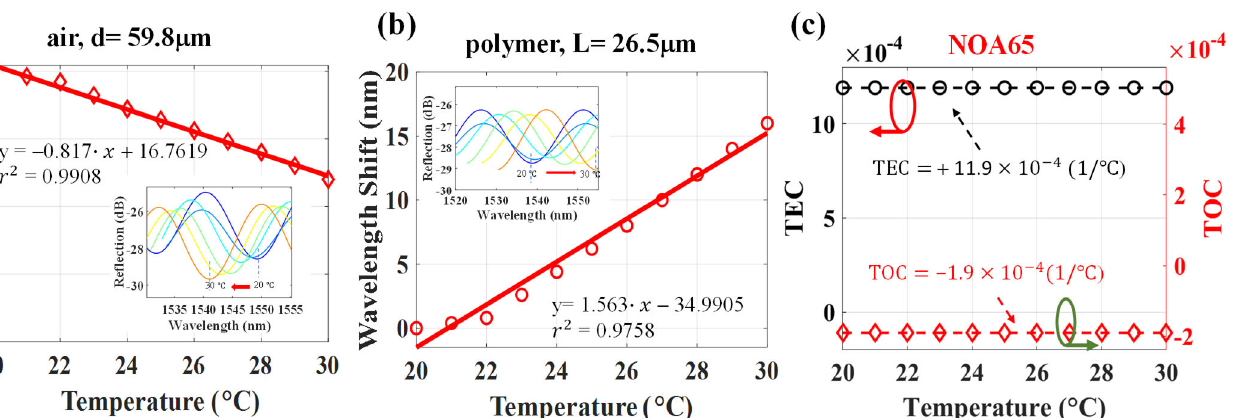
Figure 5. Wavelength shifts from 20 °C to 30 °C for the cavities of ( a ) air, ∆λ a , and ( b ) NOA61 ‐ pol ‐ ymer, ∆λ p ; ( c ) measured TEC and TOC from the results of ( a , b ).